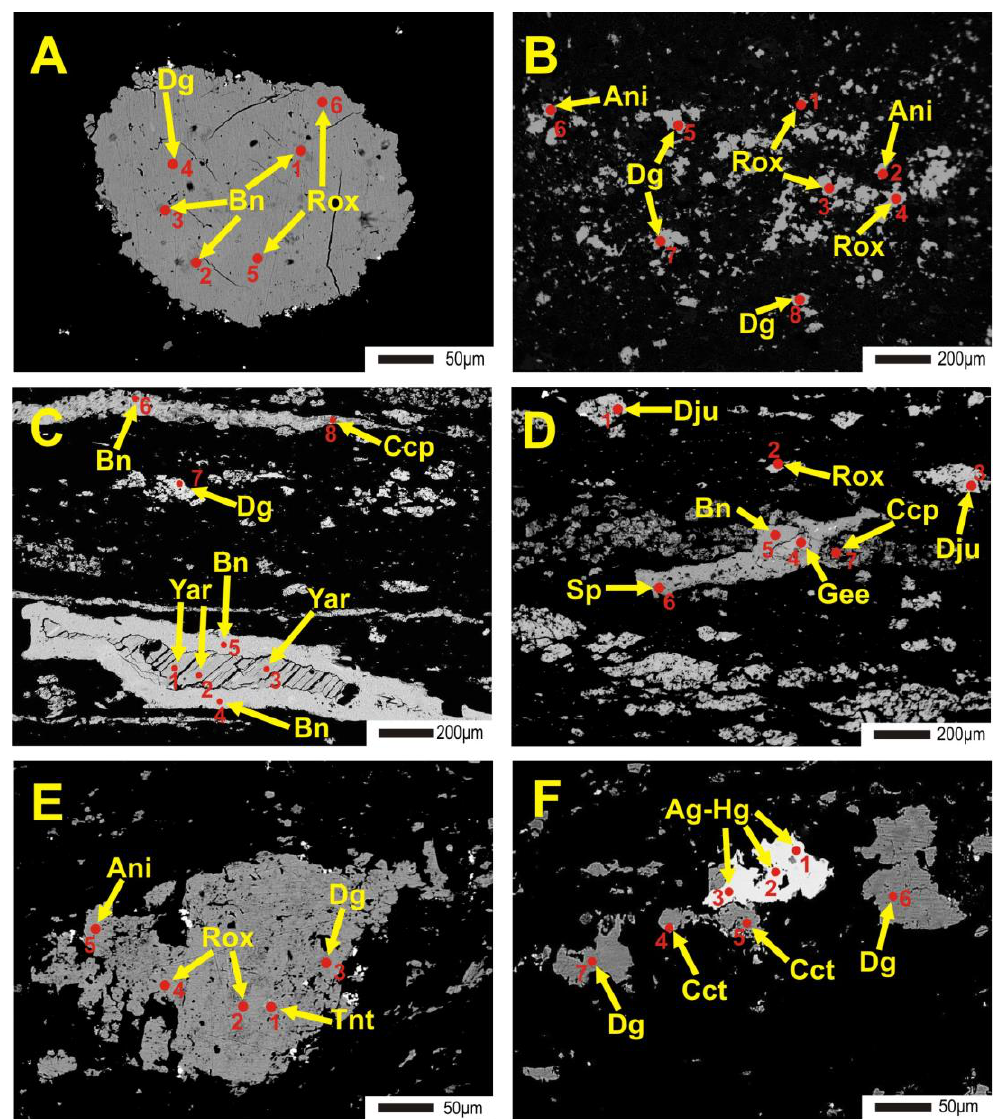
Figure 19. BSE images of ore minerals from the Cu-Ag Kupferschiefer ores on the Fore-Sudetic Monocline: ( A ) Tiny inclusions of bornite (Bn) (1–3, red points) in digenite (Dg) (4) and roxbyite (Rox) (5-6) grain. Zechstein Limestone, S-99 borehole; ( B ) roxbyite (Rox) (1,3,4), anilite (Ani) (2,6), and digenite (Dg) (5,7,8) scattered throughout carbonates, Zechstein Limestone, S-99 borehole; ( C ) rich ore mineralization represented by yarrowite (Yar) (1-3), bornite (Bn) (4-6), digenite (Dig) (7), and chalcopyrite (Ccp) (8), Kupferschiefer, S-87 borehole; ( D ) rich ore mineralization represented by djurleite (Dju) (1,3), roxbyite (Rox) (2), geerite (Gee) (4), spionkopite (Spi) (5), bornite (Bn) (5), and sphalerite (Sp) (6) accompanied by chalcopyrite (Ccp), (7), Kupferschiefer, S-87 borehole; ( E ) inclusion of tennantite (Tnt) (1) in roxbyite (Rox) (2,4), digenite (Dg) (3), and anilite (Ani) (5) aggregate, Weissliegend, S-65 borehole; and ( F ) intergrowths of silver alloys (Ag-Hg) (1–3) with chalcocite (Cct) (4,5) in association with digenite (Dg) (6,7), Weissliegend, S-65 borehole.